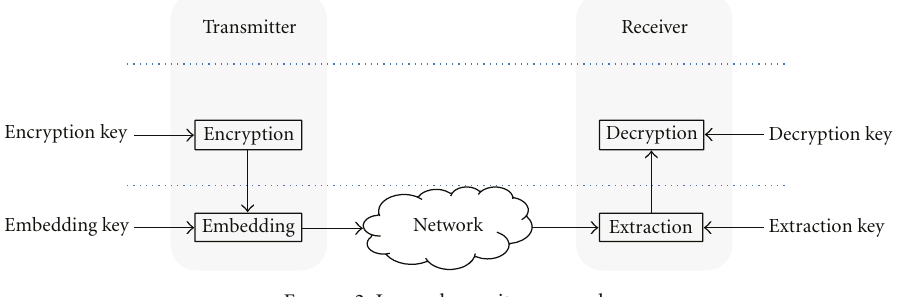
Figure 2: Layered security